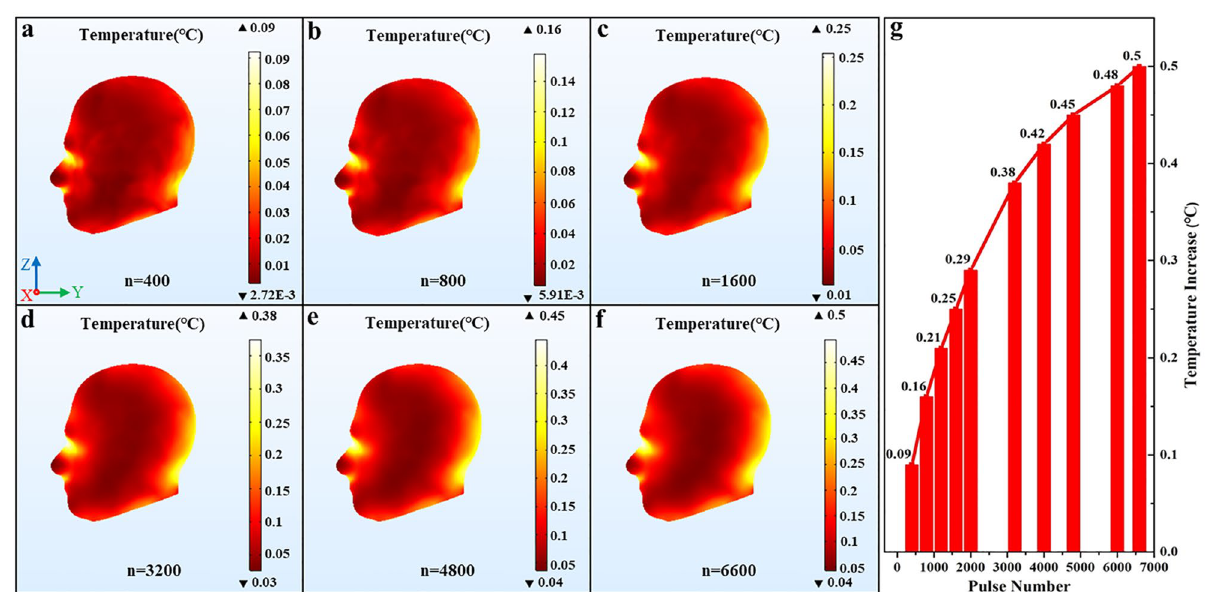
Figure 5. The temperature distribution in the human head and the variation curve of the temperature increase with different pulse total number. ( a ) n = 400, ( b ) n = 800, ( c ) n = 1600, ( d ) n = 3200, ( e ) n = 4800, ( f ) n = 6600, ( g ) the variation curve of the temperature increase. We used COMSOL Multiphysics software, version 5.4 (https:// www. comsol. com/ comsol- multi physi cs) for simulation results (Images a – f ) and Origin software, version 8.0 (https:// www. origi nlab. com/ index. aspx? go= Produ cts/ Origin) for data analysis (Image g The dose–effect between the temperature increase of the human head and the pulse total number. Temperature increases in the human head are obtained for different pulse total number of EMPs. Figure 5 shows the increases in temperature with the varied pulse total number, where, the pulse field intensity (E = 720 kV/m), the pulse width (τ = 40 ns), and the pulse repetition frequency (f = 10 Hz) remained unchanged. Figure 5a–f show the head temperature distribution where each figure respectively indicates different pulse